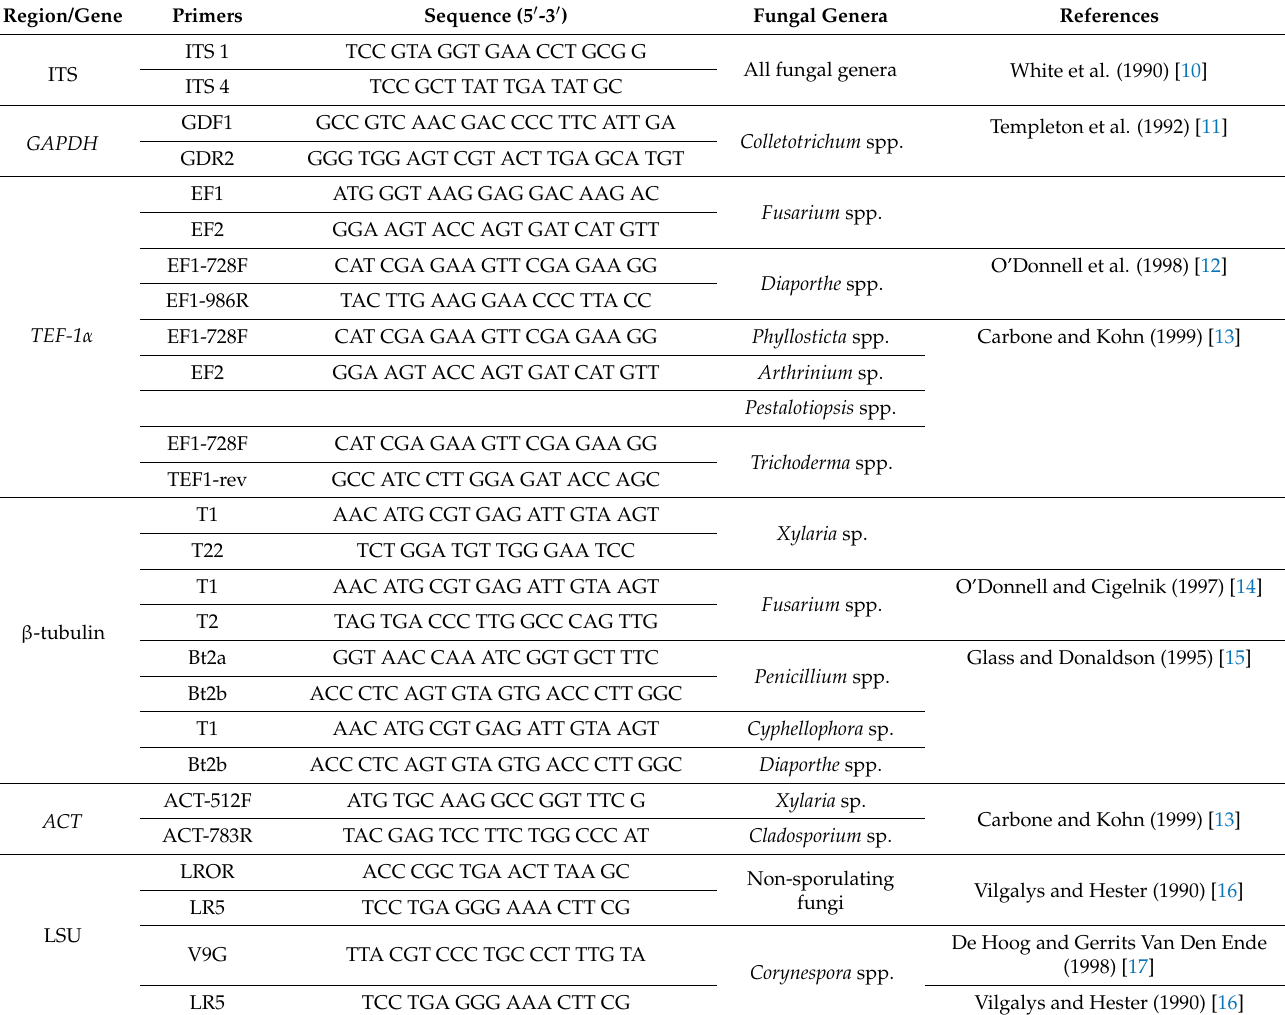
Table 1. Gene/regions used for the identification of endophytic fungi from C. castaneus spines. Region/Gene Primers Sequence (5 (cid:48) -3 (cid:48)